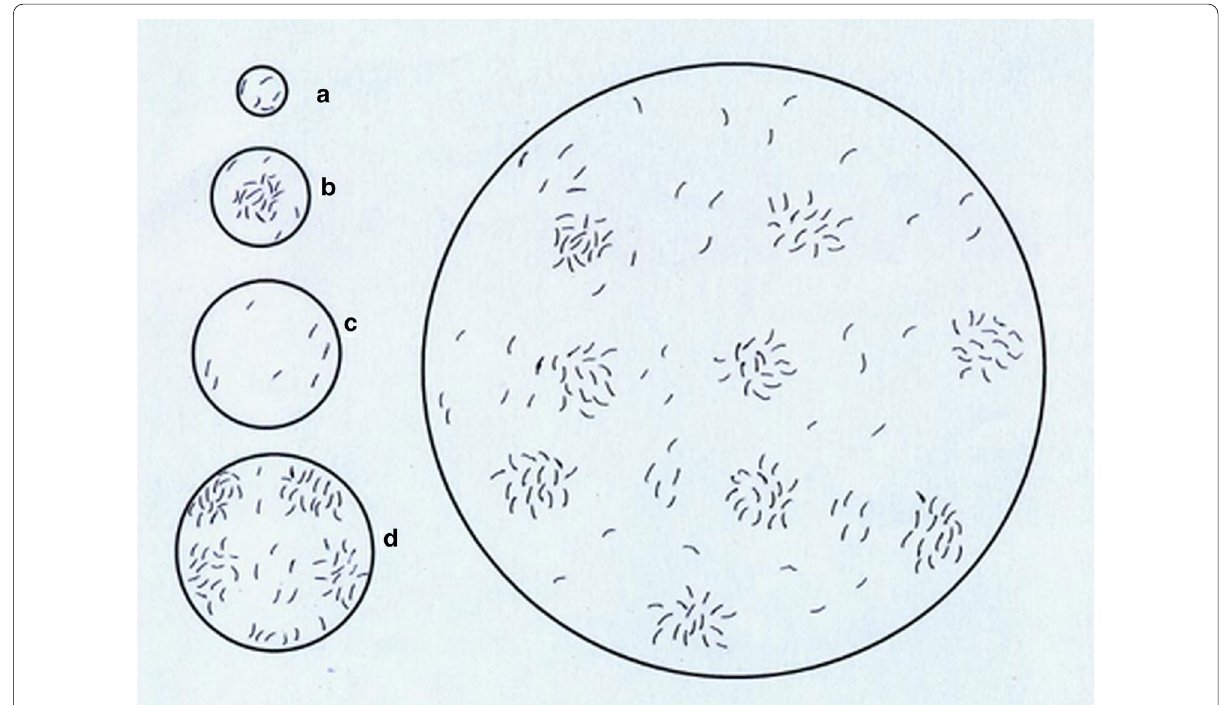
Fig. 1 Four circles (a, b, c, d) with consequent different sample sizes showing different distribution patterns of the same nematode population at the surface of the sample. These may be parts of the largest circle which has a contagious distribution with regularly distributed clumps of entomopathogenic nematodes (Abd‑Elgawad